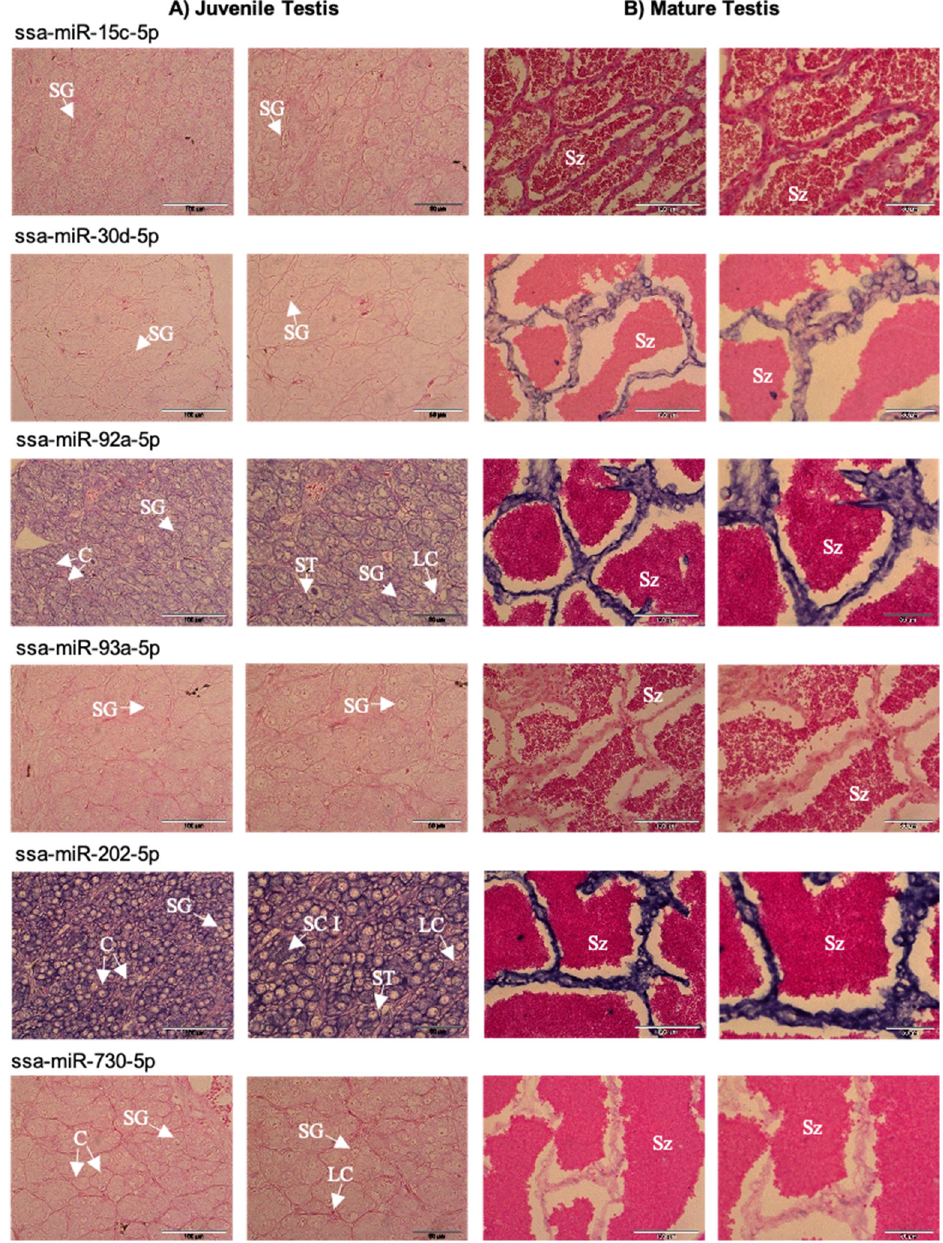
Figure 5. Localization of six miRNAs in sections of ( A ) juvenile and ( B ) mature Atlantic salmon testes, using in situ hybridization with locked nucleic acids (LNA )probes. Scale bars in the left column of each panel represent 100 µ m, while the scale bars in the right column represent 50 µ m. Abbreviations: C-cyst; LC-Leydig cell; ST- Sertoli cell; SG-spermatogonia; SC I- primary spermatocytes; Sz- spermatozoa.